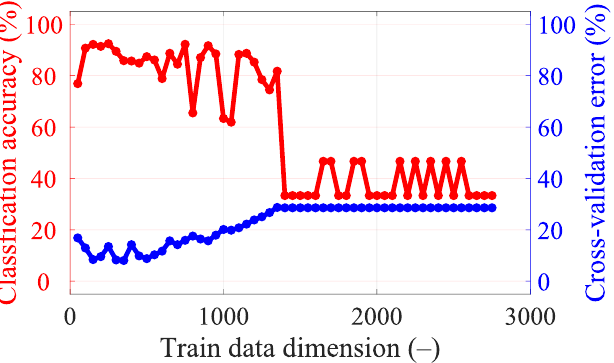
Figure A5. Classification accuracy and cross-validation error for different dimensionality reductions in the data for 25 frequency points (from 0.8 GHz, step 0.05 GHz, to 2 GHz).